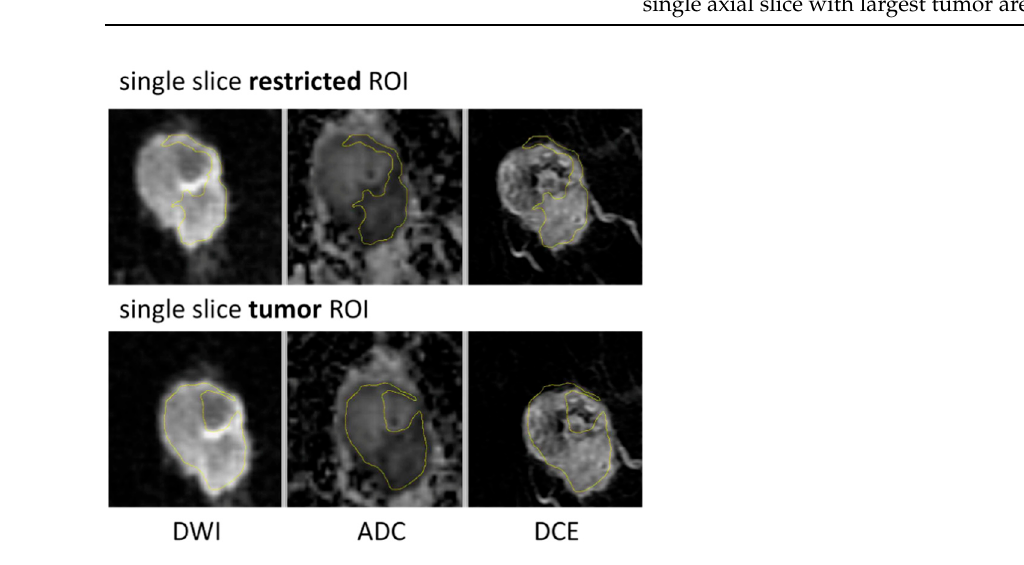
Figure 2. ROI delineation examples for single-slice restricted ROI and single-slice tumor ROI. Table 1. ROI delineation Approach.